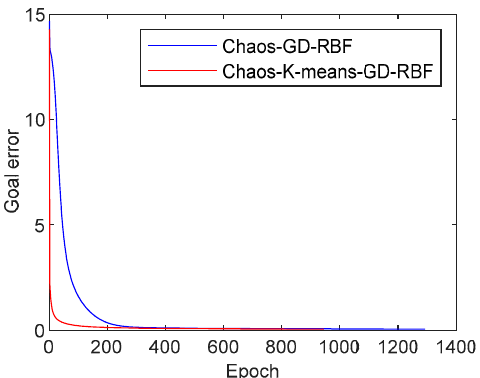
Figure 11. Comparison of the error reduction during the training process.